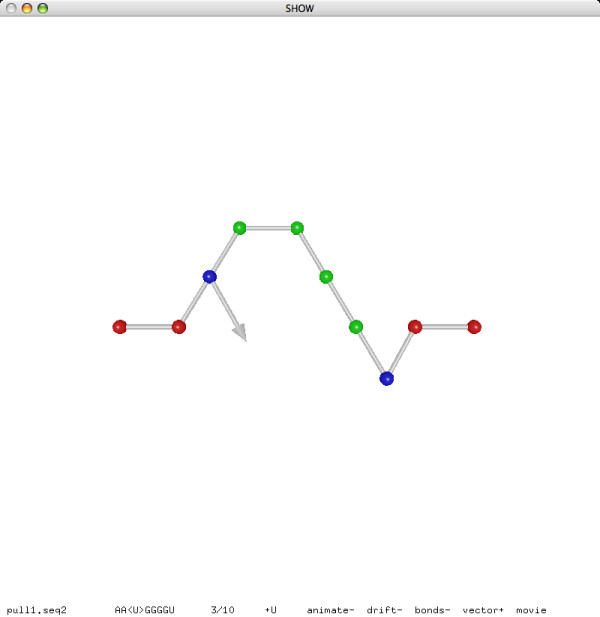
A pull move (after).